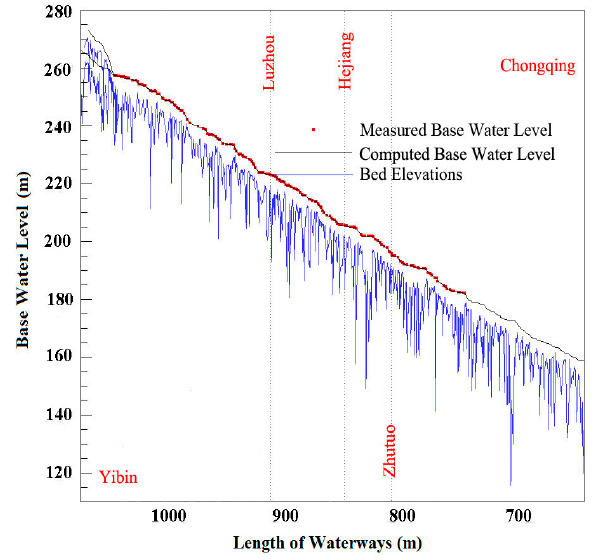
Figure 3. River bed Manning’s roughness n distributions in computational area.